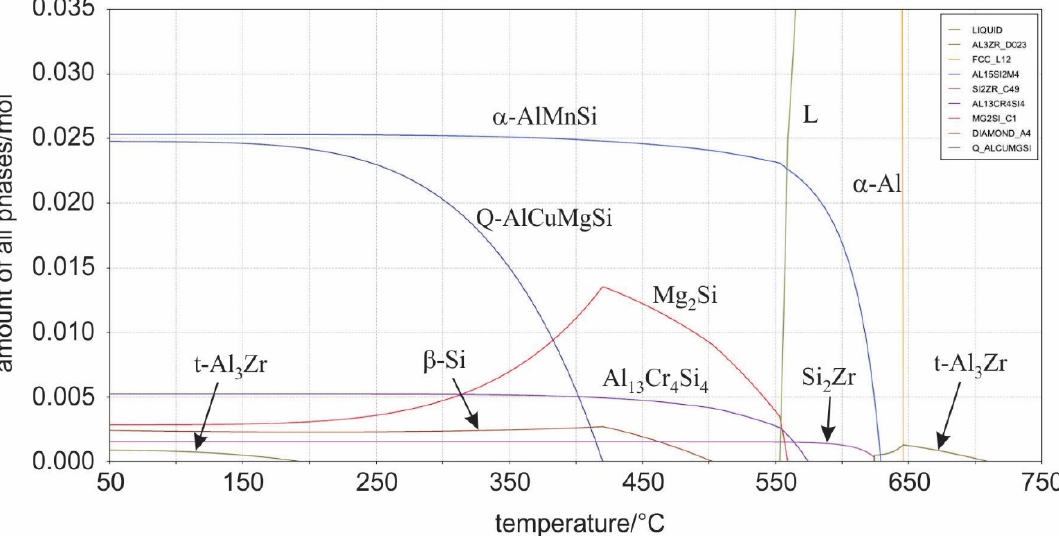
Figure 6. The calculated equilibrium phase fractions as a function of temperature. The calculated equilibrium solidus temperature T s was slightly above 750 °C. The Al 13 Cr 4 Si 4 phase was not observed in the microstructure, as chromium did not form its own phase, but it was incorporated into α -AlMnSi.